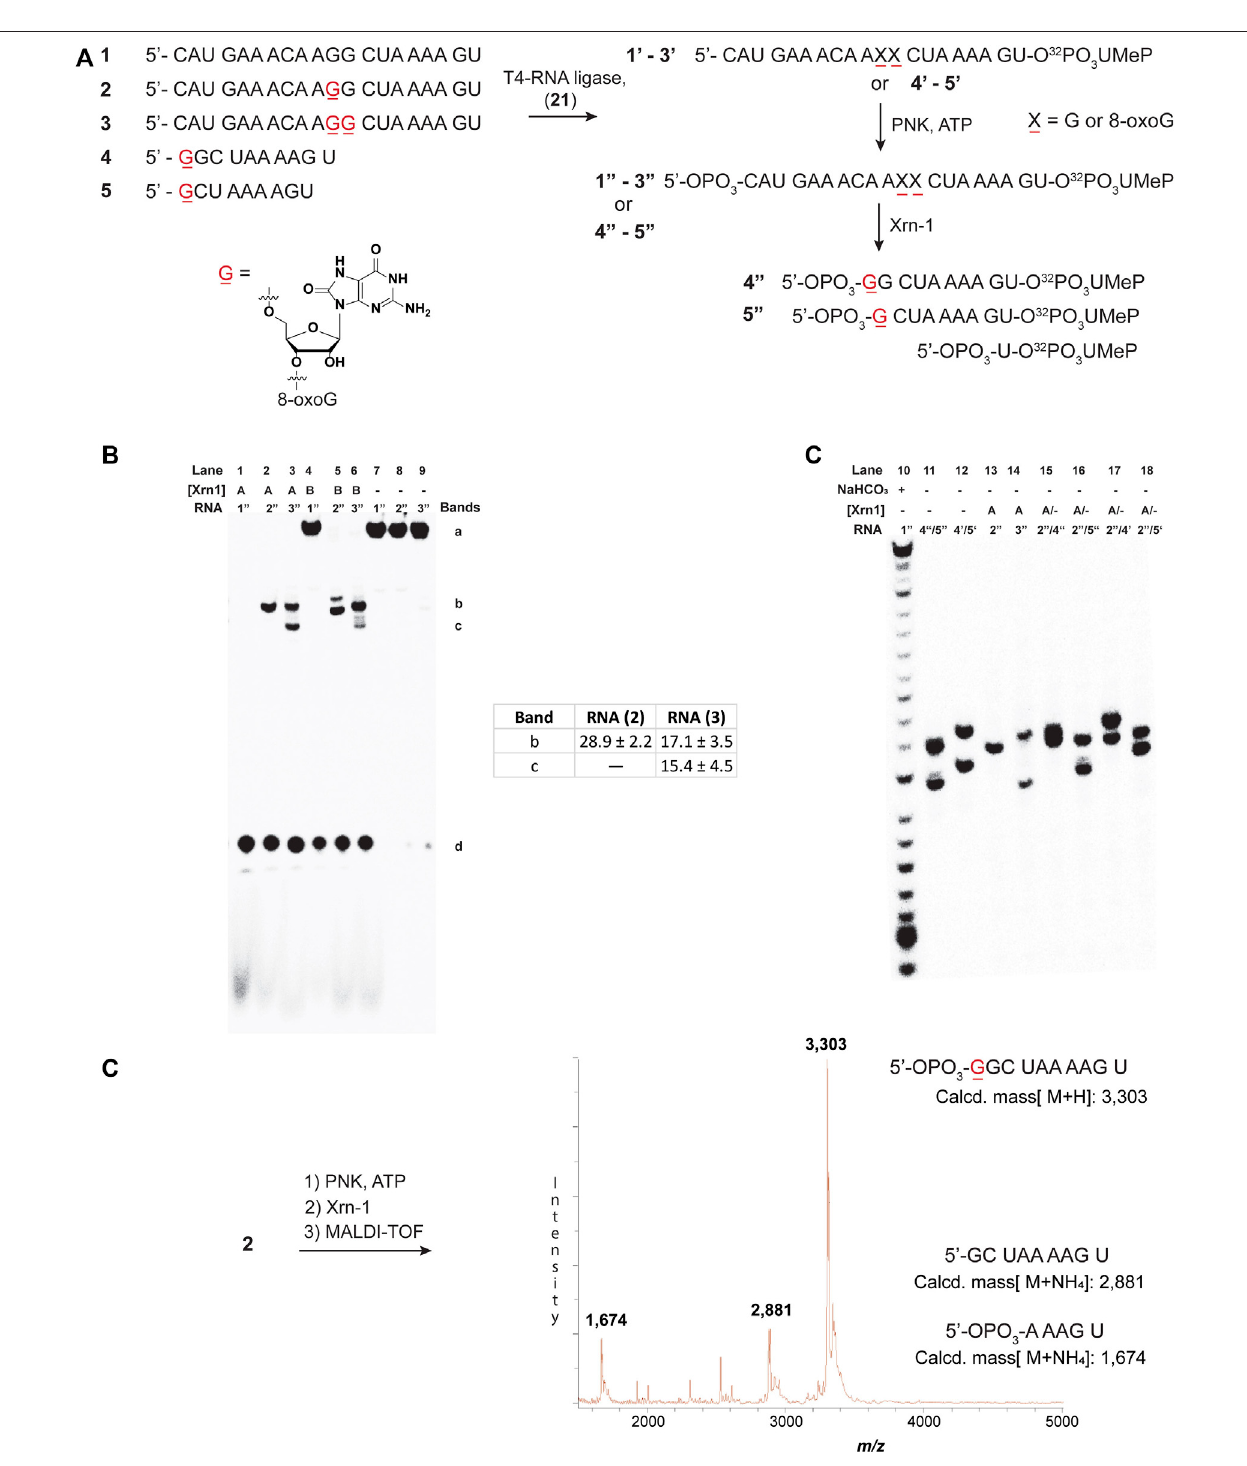
FIGURE 1 | Sequences 1 - 5 and the overall process for 3 ′ -radiolabeling (using nucleotide transformation 20 → 21 ), and 5 ′ -phosphorylation of the corresponding oligonucleotides (A) ; and 20% denaturing PAGE of oligonucleotides 1 ″ -3 ″ in the presence of Xrn-1 in the absence (B) and presence of markers 4 and 5 (C) . The difference between lanes 1-3 and 4-6 in (B) represents a 10-fold dilution in [Xrn-1], respectively, where A (cid:2) 0.12 pg, B (cid:2) 0.012 pg, or ( − ) no enzyme added, per experiment. Reactions were carried out in buffered solutions (100 mM NaCl, 50 mM Tris ▪ HCl, 10 mM MgCl 2 , 1 mM DTT, pH 7.9) by incubating for 2 h (rt). Further characterization of the fragment of interest was obtained via MALDI-TOF, which matched the mass of ON 4 phosphorylated at the 5 ′ -end 4 (D) .